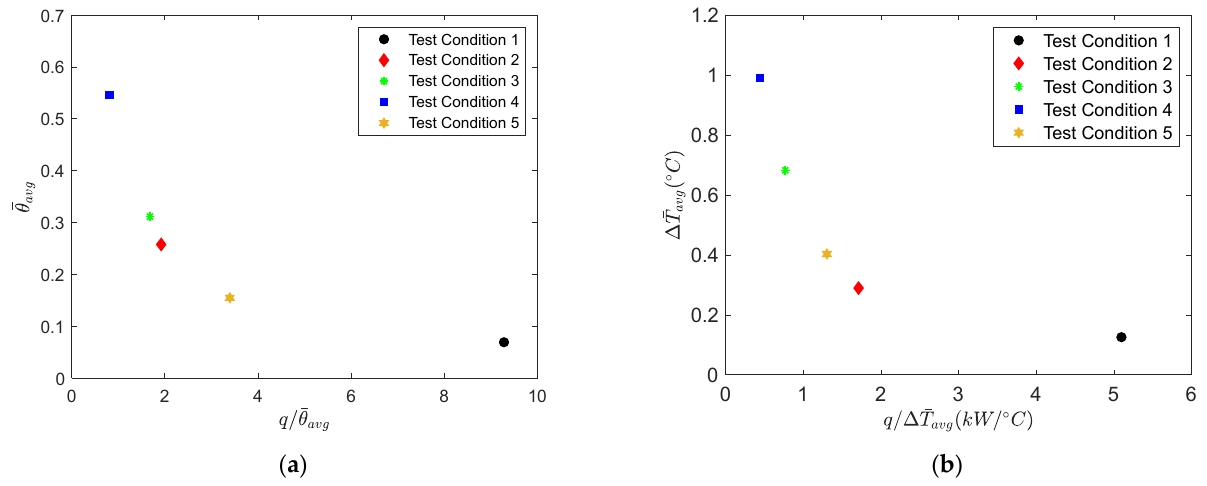
Figure 8. Comparison of ( a ) average dimensionless temperature difference at corresponding average heat transfer per dimensionless temperature difference and ( b ) average temperature difference at corresponding average heat transfer per °C of cooling at each test condition.